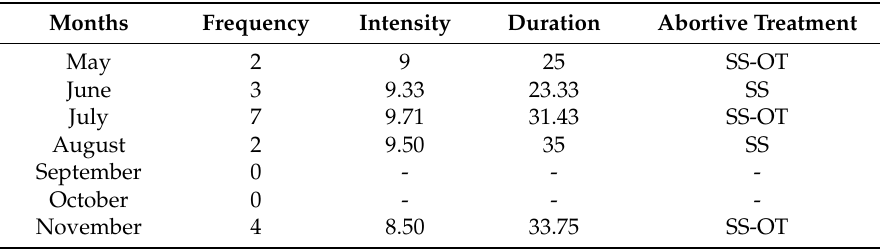
Table 2. Evolution of headache